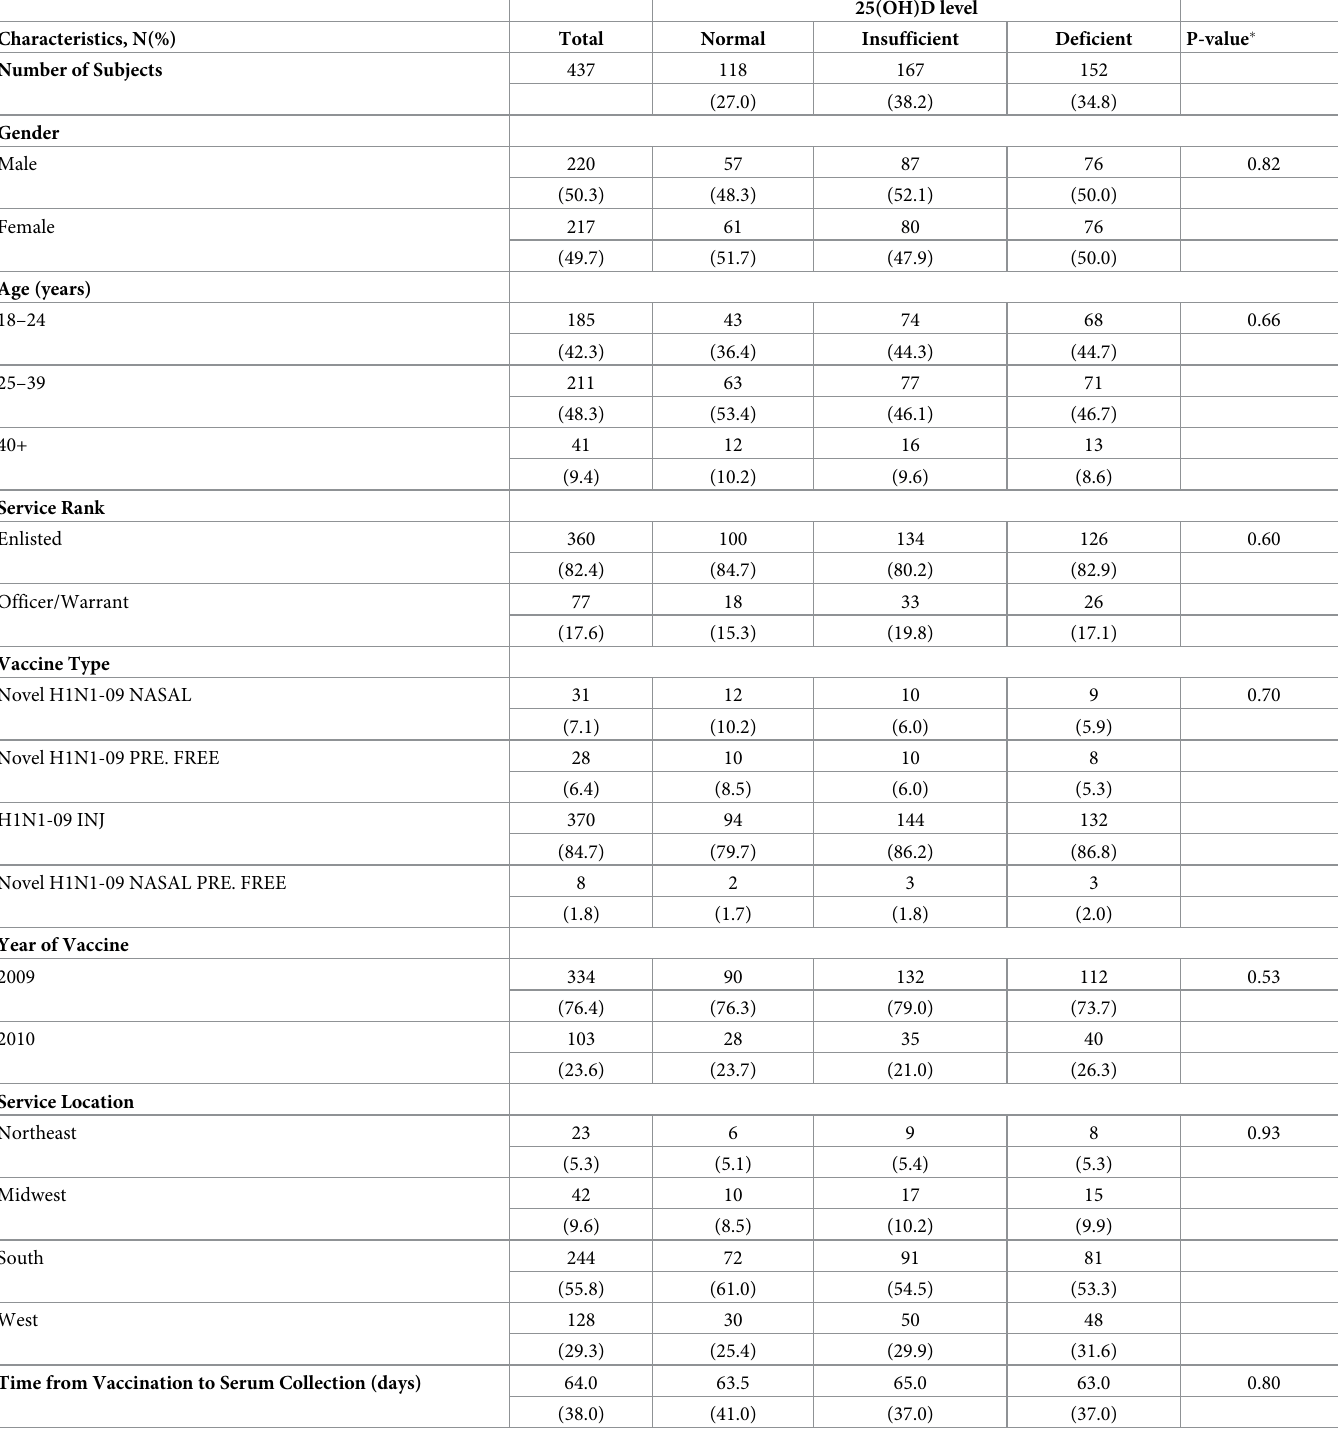
Table 1. Baseline characteristics by serum 25(OH)D